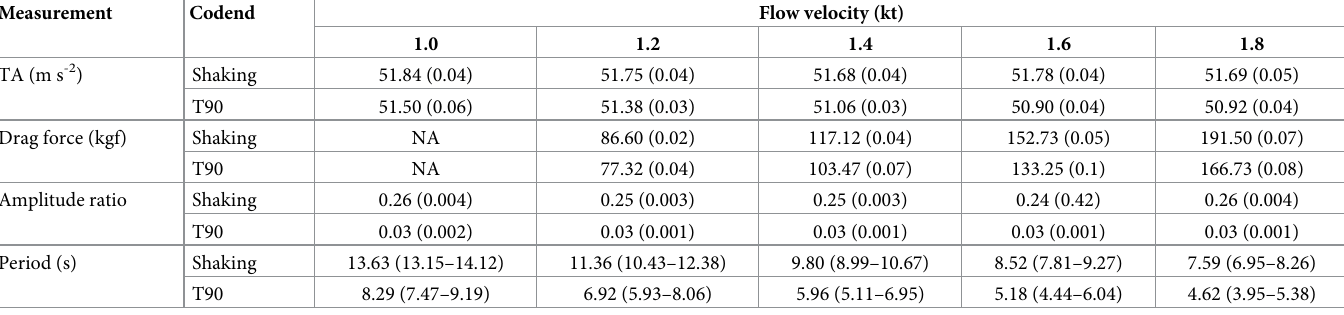
Table 2. The mean values for total acceleration (TA), amplitude ratio, and period of a shaking and T90 codend tested in five different flow velocities during a flume tank test.